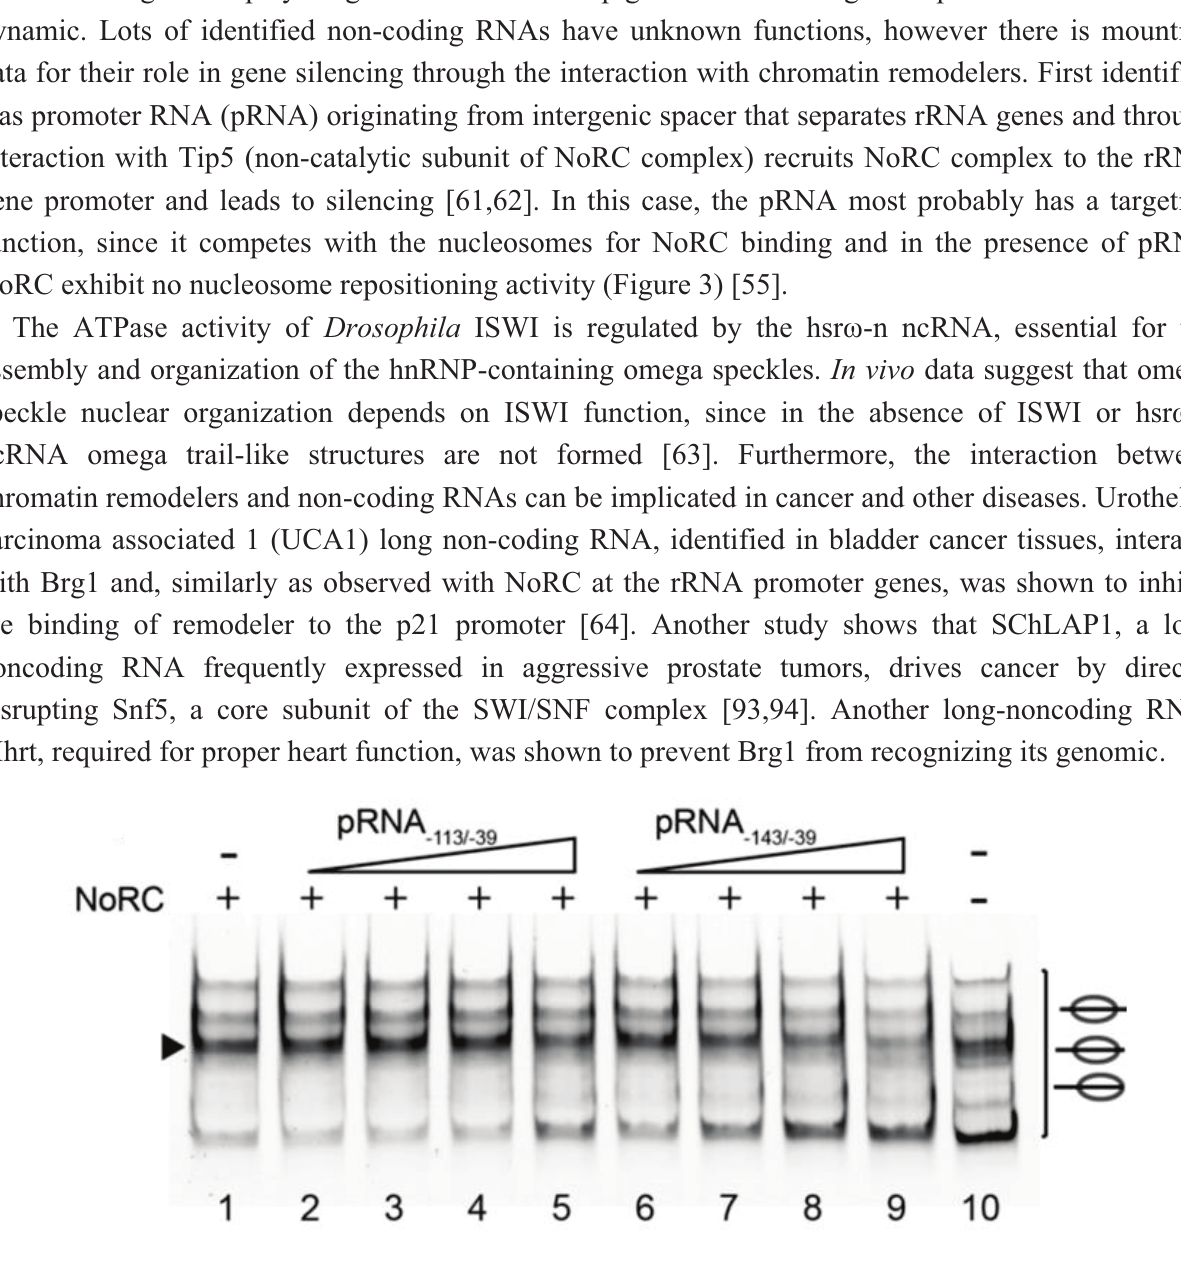
Figure 3. pRNA inhibits the activity of NoRC. Nucleosomes assembled on the − 190 to +90 rDNA DNA fragment were incubated with NoRC, ATP and increasing concentrations of pRNA − 143/ − 39 and pRNA − 113/ − 39 . The remodeling reactions were analyzed by EMSA. The arrowhead indicates the nucleosome at the − 120/+27 position